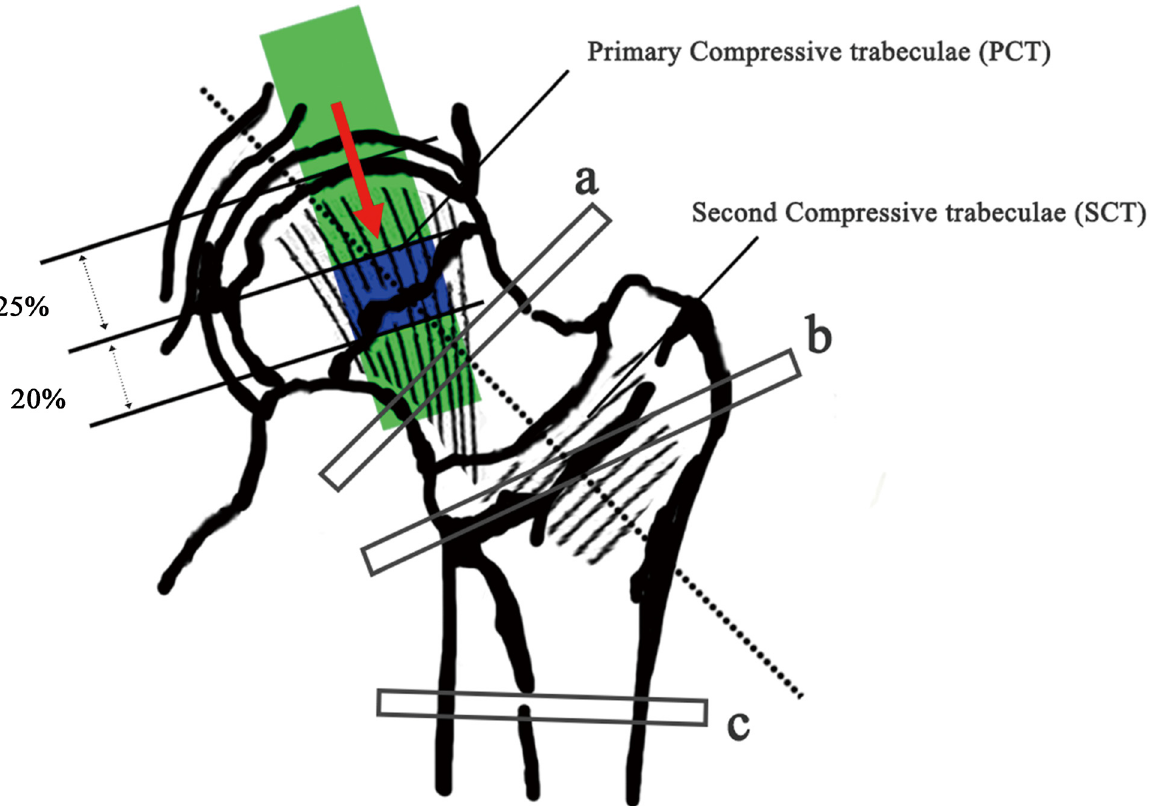
Fig 1. Weight-bearing system of the proximal femur and trabecular column extracted from QCT and mechanical test. The primary (PCT) and second compressive trabeculae (SCT) were delineated in the figure. After extracted from femoral head, PCT was cut into three segments. The first segment was ~25% of the diameter of the femoral head and the second segments was ~20%. The green box shows the extracting channel of the femoral head, while the blue box shows the 20% diameter length of the trabecular column that was used for the QCT scan and mechanical test. The red arrow indicated the loading direction of mechanical test. a, The femoral neck area of interest (NN); b, the trochanteric area of interest (IT); and c, the shaft area of interest (FS) during the analysis of BMD and